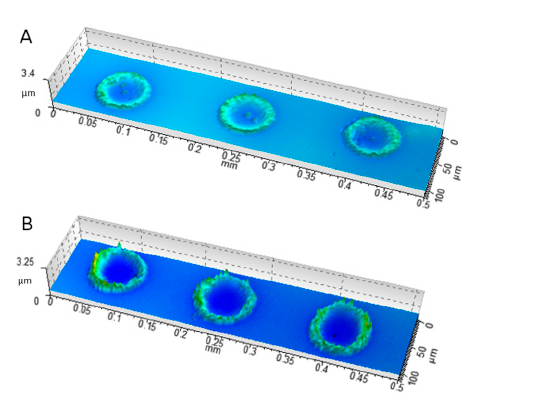
Figure 8. SWLI images of 150 dpi 5 mg/mL suspension deposits of ( A ) unloaded MSN–PEI and ( B ) drug-loaded MSN–PEI–F15 on HPMC.